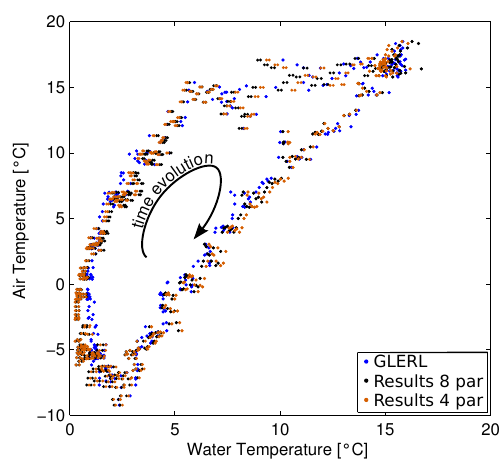
Fig. 12. Comparison of the hysteresis cycles between daily air and surface water temperatures, as derived by the data and by the eight- and four-parameter versions of the model. Hysteresis cycles refer to the mean year, calculated over the period 1994–2005, using GLERL and NDBC data for T w and T a , respectively (GLERL myr simulation).